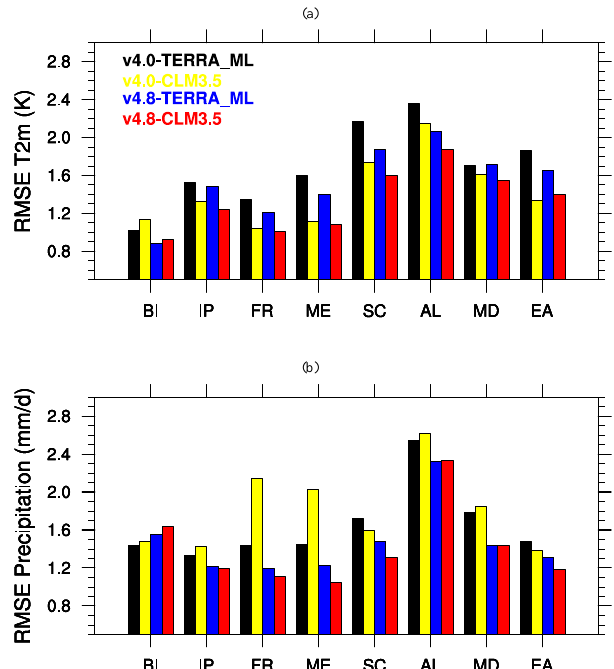
Fig. 4. Model performance for a) 2-meter temperature and b) precipitation, for the different model experiments. BI: British Isles; IP: Iberian Peninsula; FR: France; ME: Mid-Europe; SC: Scandinavia; AL: Alps; MD: Mediterranean; EA: Eastern Europe. The considered score is the RMSE calculated from the differences (model minus CRU) taken at each grid cell and for each month (monthly means) over the time period 1986-2006.